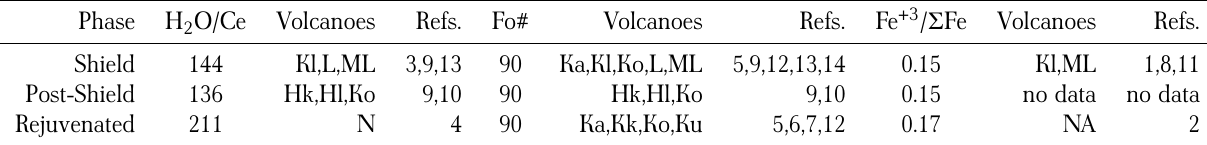
Table 2: Model parameters for calculating melt-equilibration conditions for the Hawaiian Islands. H from melt inclusions and their olivine hosts shown in Database S2; Fe + 3 / Σ Fe, S, and Mg# data shown in Database S3. Volcanoes: Hk = Haleakala; Hl = Haulalai; Ka = Kauai; Kk = Koko; Kl = K¯ılauea; Ko = Koolau; Ku = Kaula; L = L¯oi ‘ hi; ML = Mauna Loa; N = Ni ‘ ihau; NA = North Arch. References: 1 = Brounce et al. [2017]; 2 = Dixon et al. [1997]; 3 = Dixon and Clague [2001]; 4 = Dixon et al. [2008]; 5 = Garcia et al. [2015]; 6 = Garcia et al. [2016]; 7 = Garcia et al. [2022]; 8 = Helz et al. [2017]; 9 = Marske and Hauri [2019]/Tucker et al. [2019]; 10 = Moore et al. [2021]; 11 = Moussallam et al. [2016]; 12 = Sakyi et al. [2012]; 13 = Sides et al. [2014]; 14 = Wieser et al.